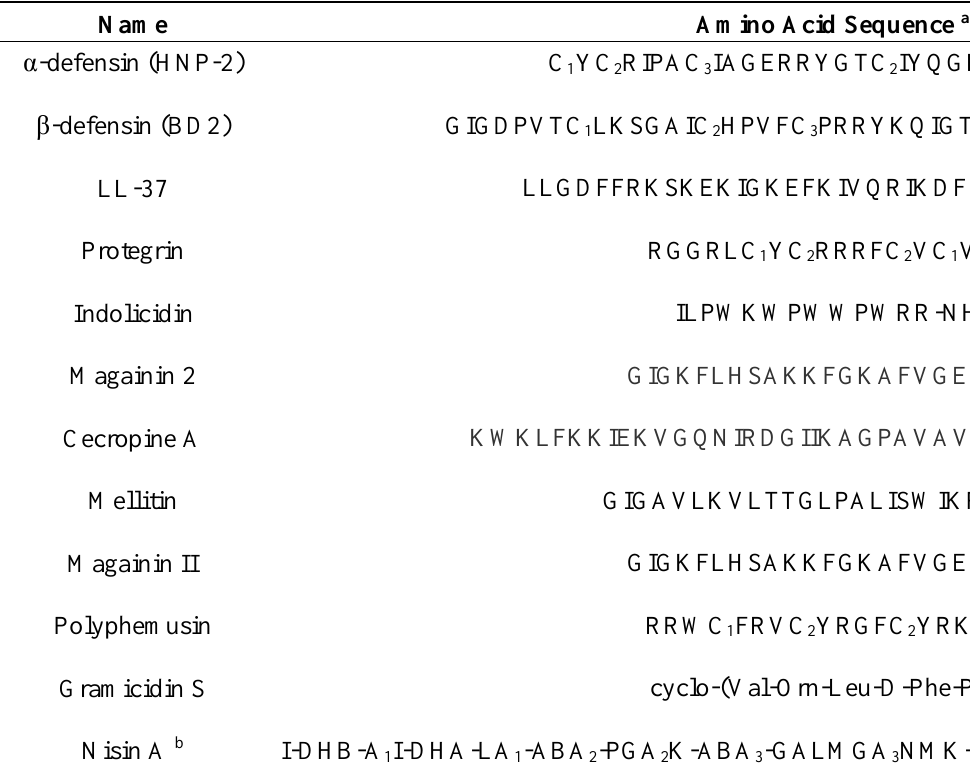
Table 1. Overview of some natural antimicrobial